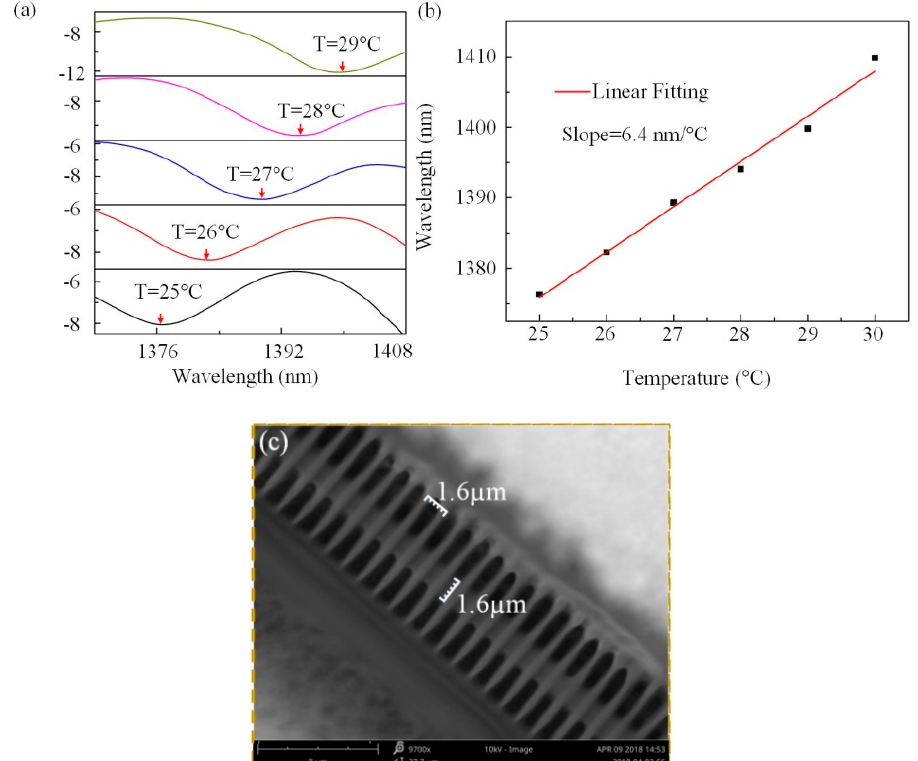
Figure 5. ( a ) Transmission spectral evolution of the POFI as the temperature is increased from 25 ◦ C to 30 ◦ C. ( b ) Dip wavelength versus temperature from 25 ◦ C to 30 ◦ C. ( c ) Scanning electron microscope (SEM) image of the POFI.